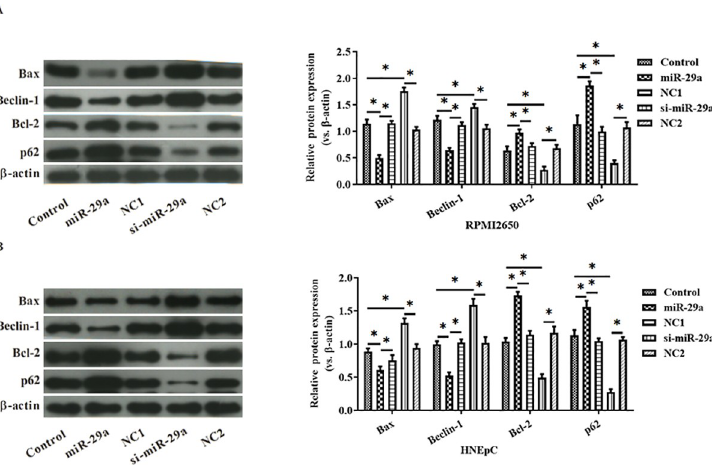
Fig 3. The effects of miR-29a on the expression of Bax, Beclin1, Bcl-2 and p62 in RPMI2650 cells (A) and HNEpC cells (B) were analyzed by Western Blot. � : p < 0.05.